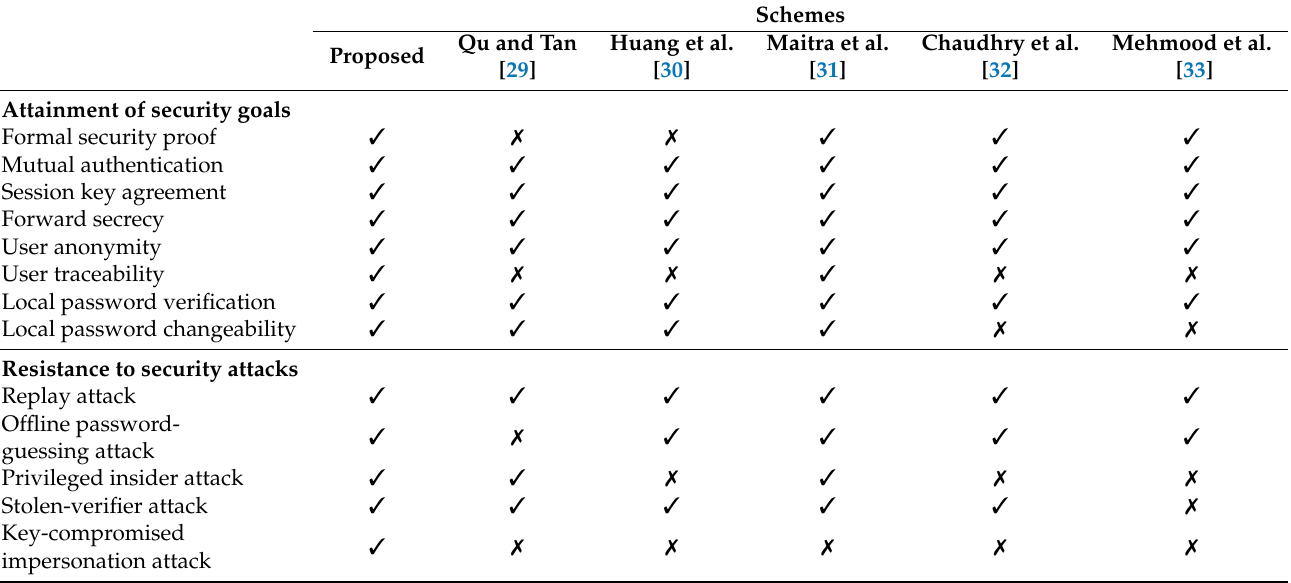
Table 4. Attainment of security goals and resistance to security attacks of the proposed scheme and other similar